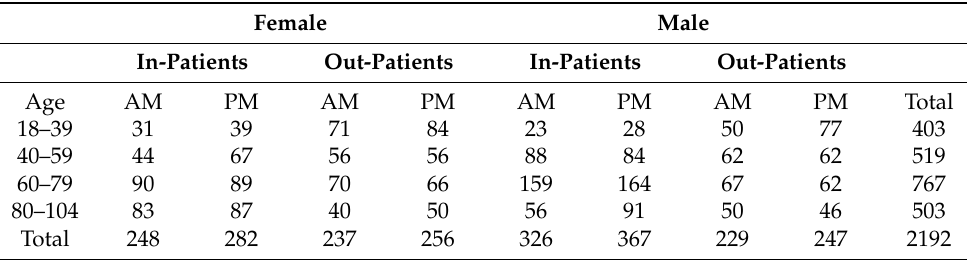
Table 1. Number of participants in each sex, age group, in-patient vs. out-patient, and AM/PM category.